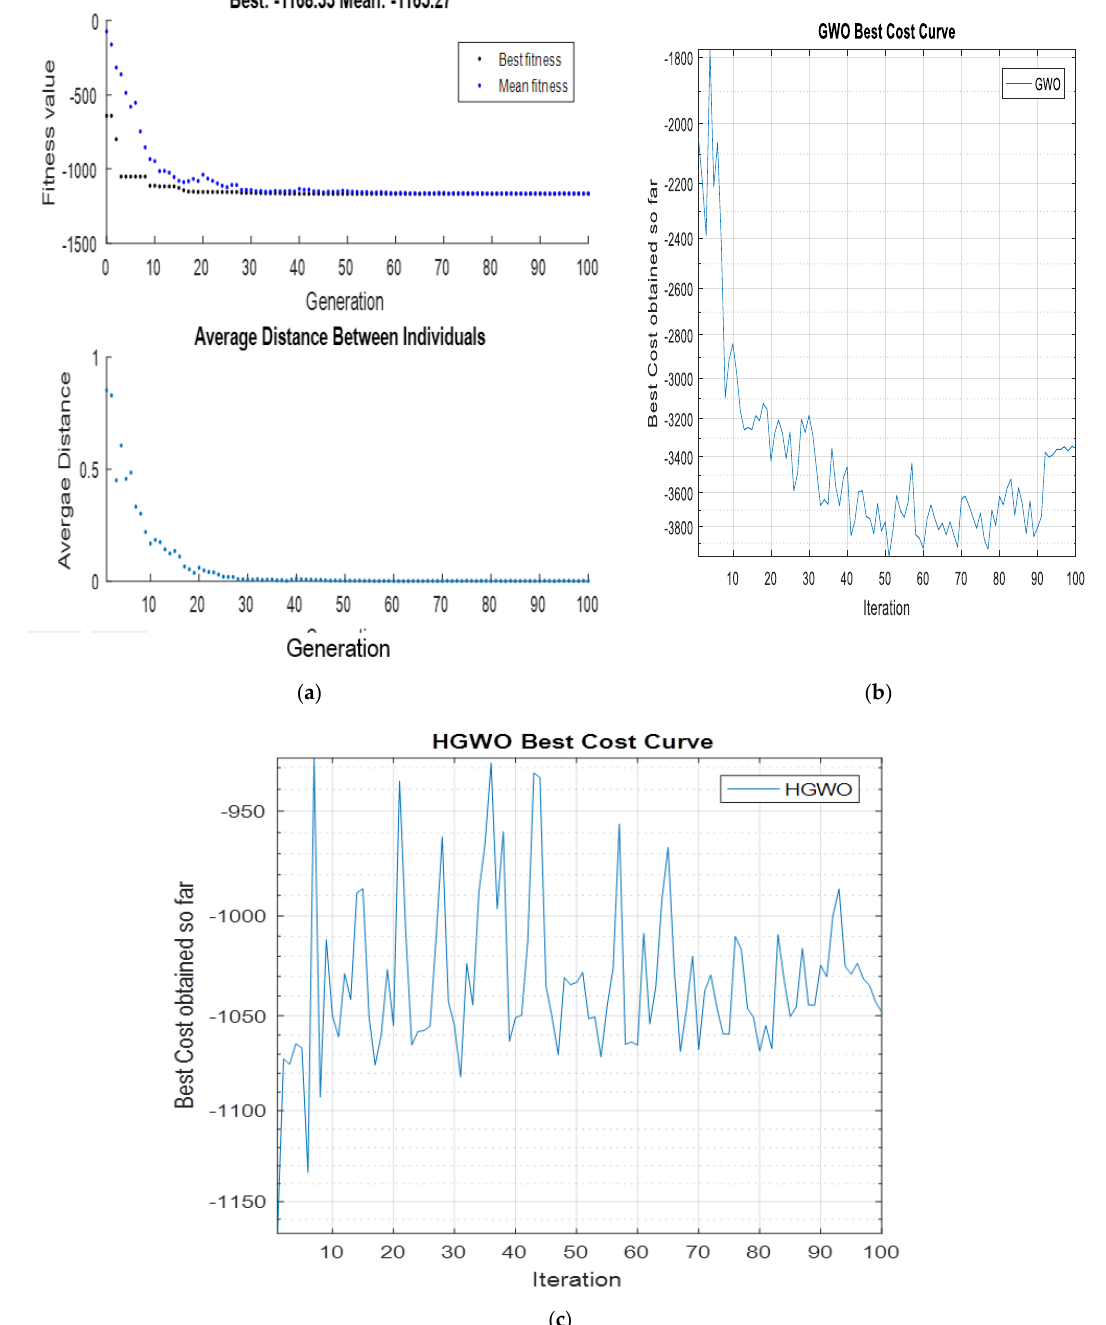
Figure 6. The cost graphs for a single AUV applying: ( a ) GA; ( b ) GWO; ( c ) HGWO. The path is not a straight line but a curve, since the AUV has to avoid collision with obstacles in its path. The optimized cost curves obtained based on the GWO and HGWO